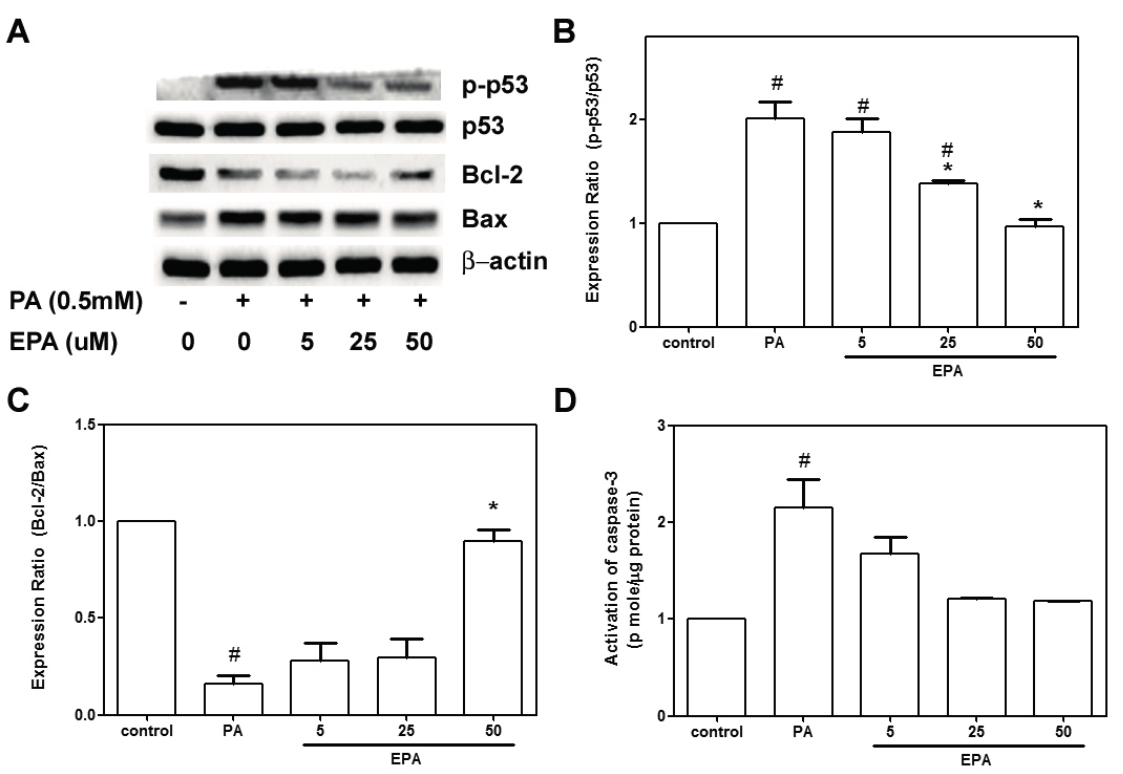
Figure 3. Effects of EPA on the PA-mediated upregulation of apoptosis-related proteins. The HUVECs were pretreated with the indicated concentrations of EPA for 2 h followed by further stimulation with PA (0.5 mM) for another 18 h. The expressions of phosphor-p53, p53, Bcl-2, Bax and β -actin were determined by western blot ( A ); Representative western blots and phosphor-p53/p53 ratio ( B ) and Bcl-2/Bax ratio ( C ) summary data are shown. These results were confirmed by densitometric analyses; Caspase 3 activity was measured with an EnzCaspase-3 assay kit ( D ); The values are presented as the means ± the S.E.s of three separate experiments. # p < 0.05 vs. untreated control; * p < 0.05 vs. PA